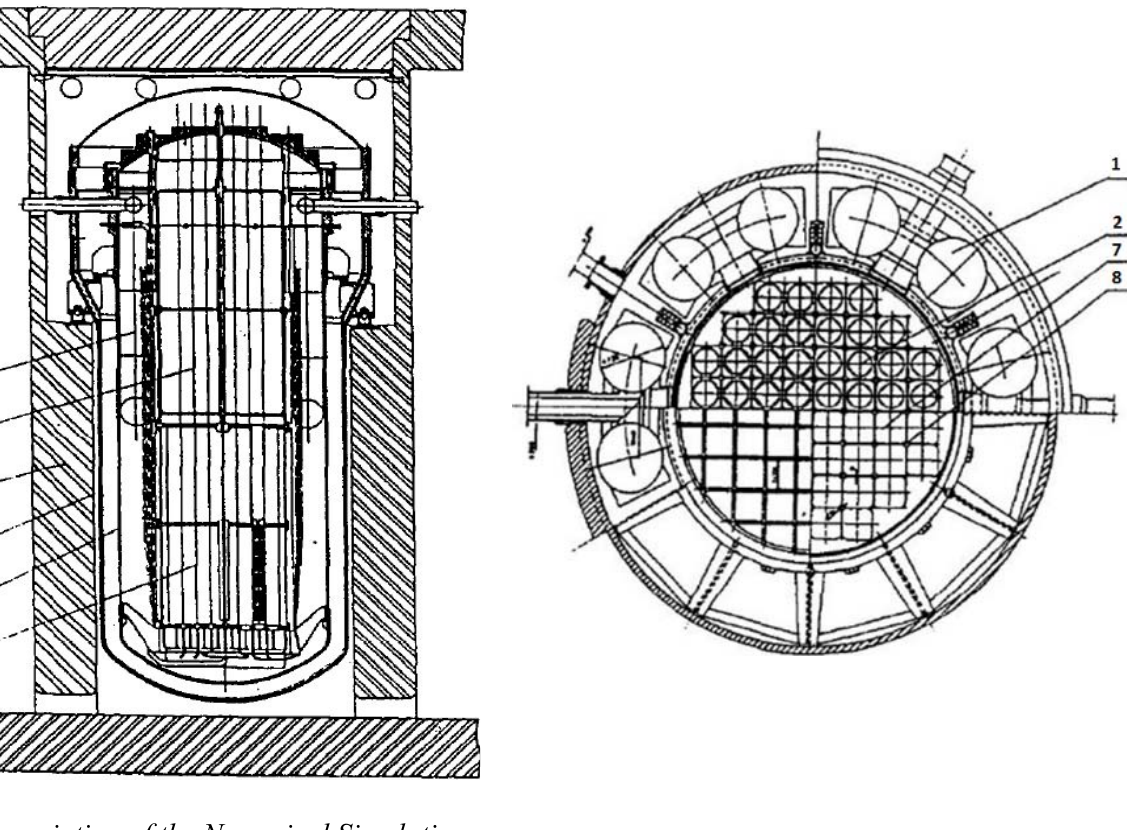
Figure 1. Structure and cross section of the NHR: (1) Primary heating exchanger; (2) Riser; (3) Biological shield; (4) Containment; (5) Pressure vessel; (6) Core; (7) Fuel elements and (8) Control